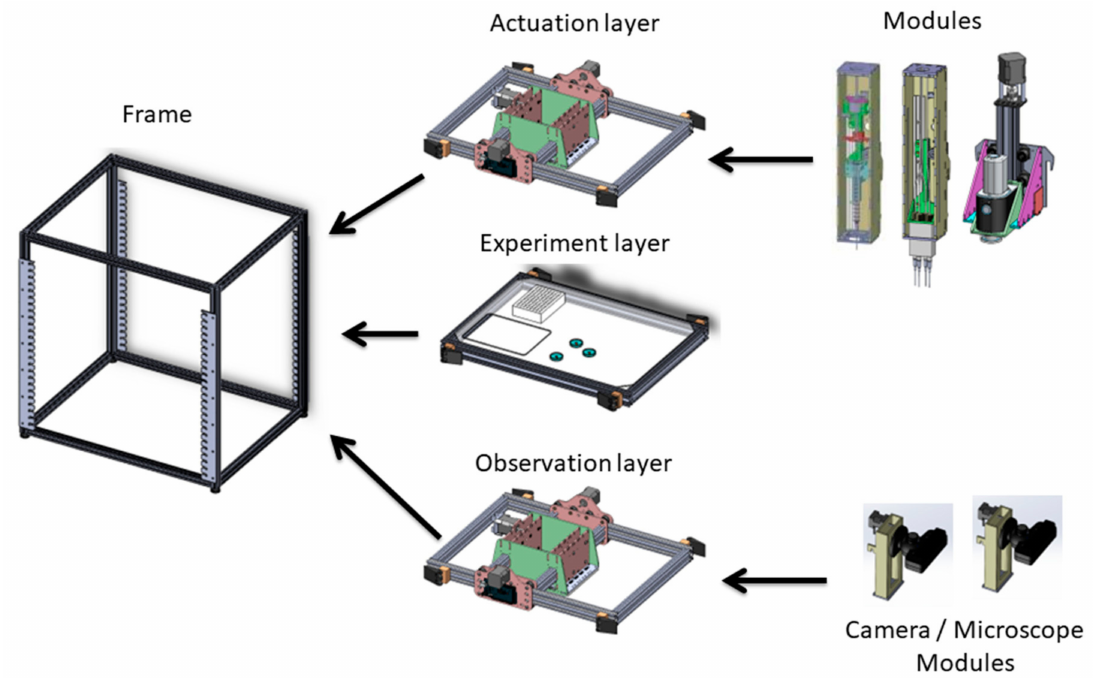
Figure 2. Overview of modularity in EvoBot. Users can decide the layers that they need for their experiments and attach modules with specific functionality to the